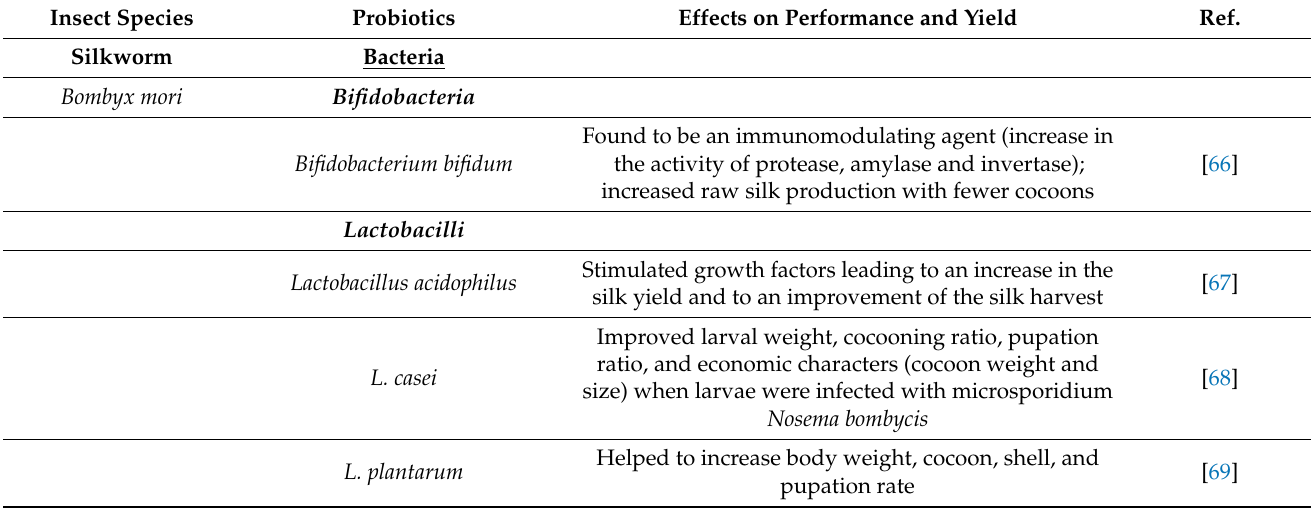
Table 1. A summary of probiotics tested on insects mass-reared for food and feed with the objective of improving insect performance or fitness against natural pathogens in the mass rearing environment. The table does not include data where bacteria/yeast have been provided to the insect as a probiotic to test its efficacy against a specific human pathogen in vivo, nor does it include insects reared for sterile insect technique programmes. Effects on Performance and Yield